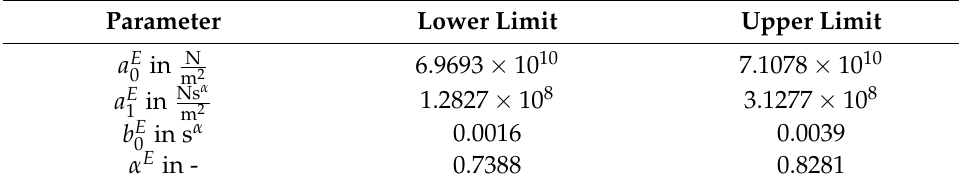
Figure 6. Normalized errors. ( a ) Real part; ( b ) imaginary part. Table 6. Limit values after the curve fit.